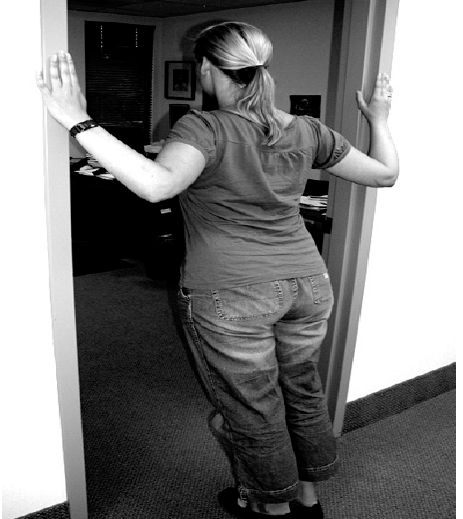
Figure 7. Pectoralis minor stretching. Standing in an open doorway with hands on door jams at shoulder level. Letting the body fall forward stretches the pectoralis minor muscles. The degree of stretching is controlled by the position of the feet either closer to or farther from the threshold line.